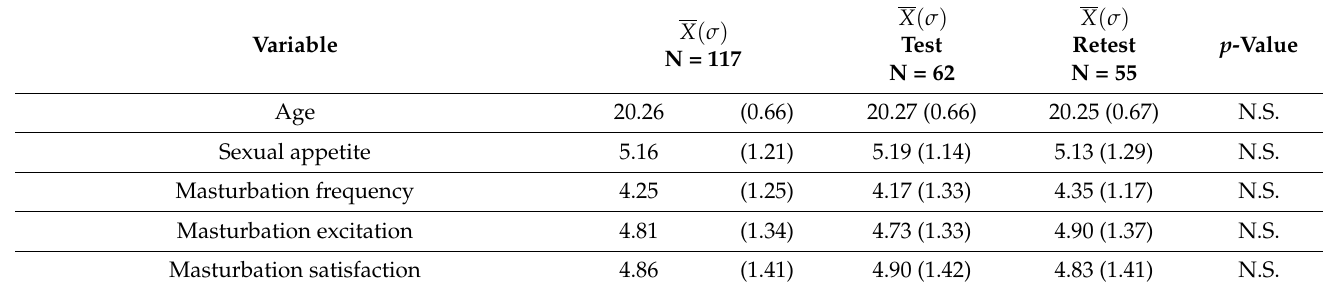
Table A2. Test–retest reliability. Descriptive and bivariant